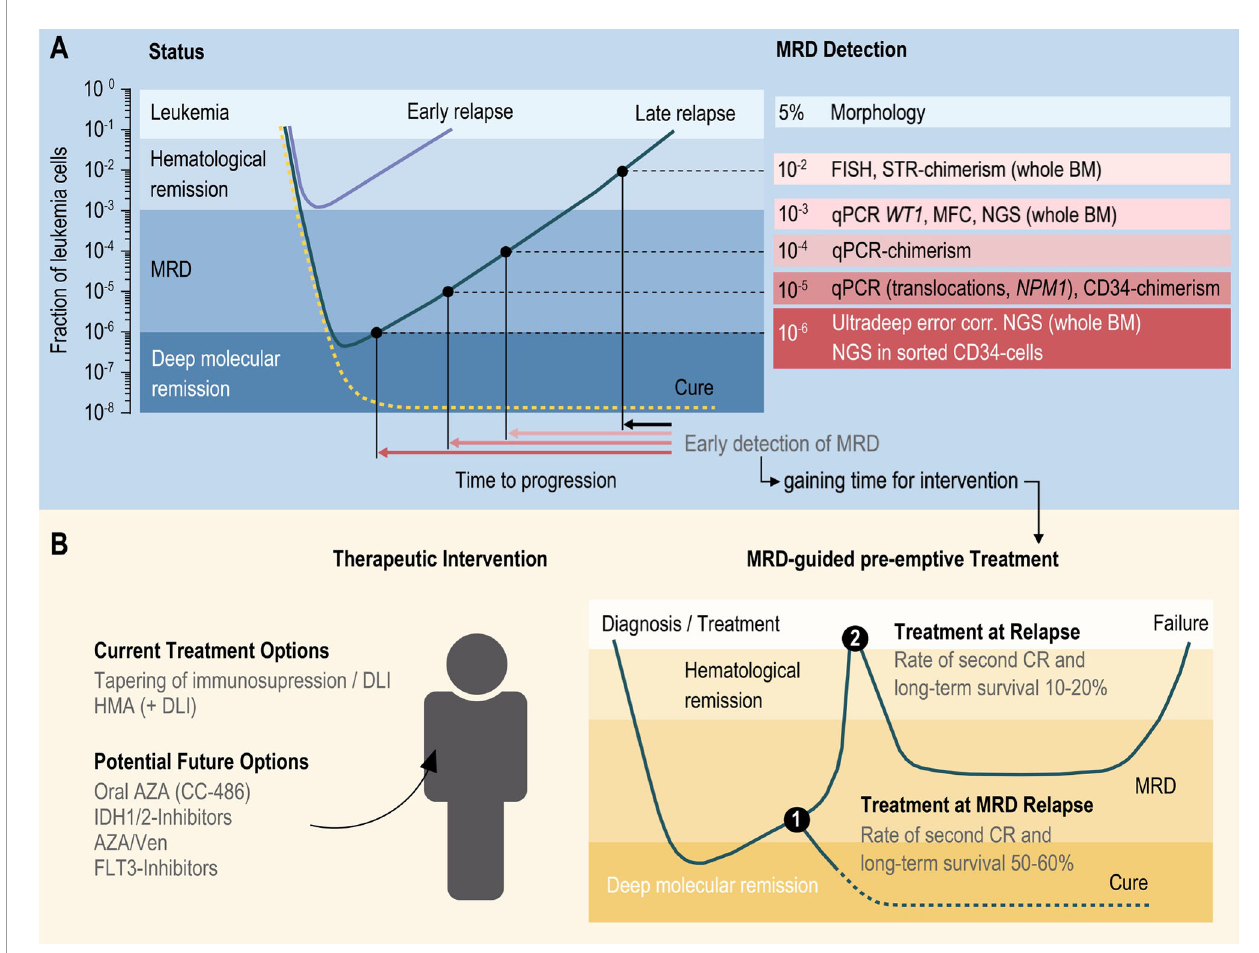
FIGURE 1 | Schematic illustration of MRD detection (A) and treatment options of AML patients following allogeneic HCT (B) . MRD measurable residual disease; FISH fl uorescence in situ hybridization; STR short tandem repeat; BM bone marrow; qPCR quantitative polymerase chain reaction; WT1 Wilms tumor protein 1; MFC multicolor fl ow cytometry immunophenotyping; NGS next generation sequencing; NPM1 Nucleophosmin 1; HMA hypomethylating agents; DLI donor lymphocyte infusion; AZA azacytidine; Ven Venetoclax; CR complete remission; IDH Isocitrate dehydrogenase; FLT3 Fms related receptor tyrosine kinase